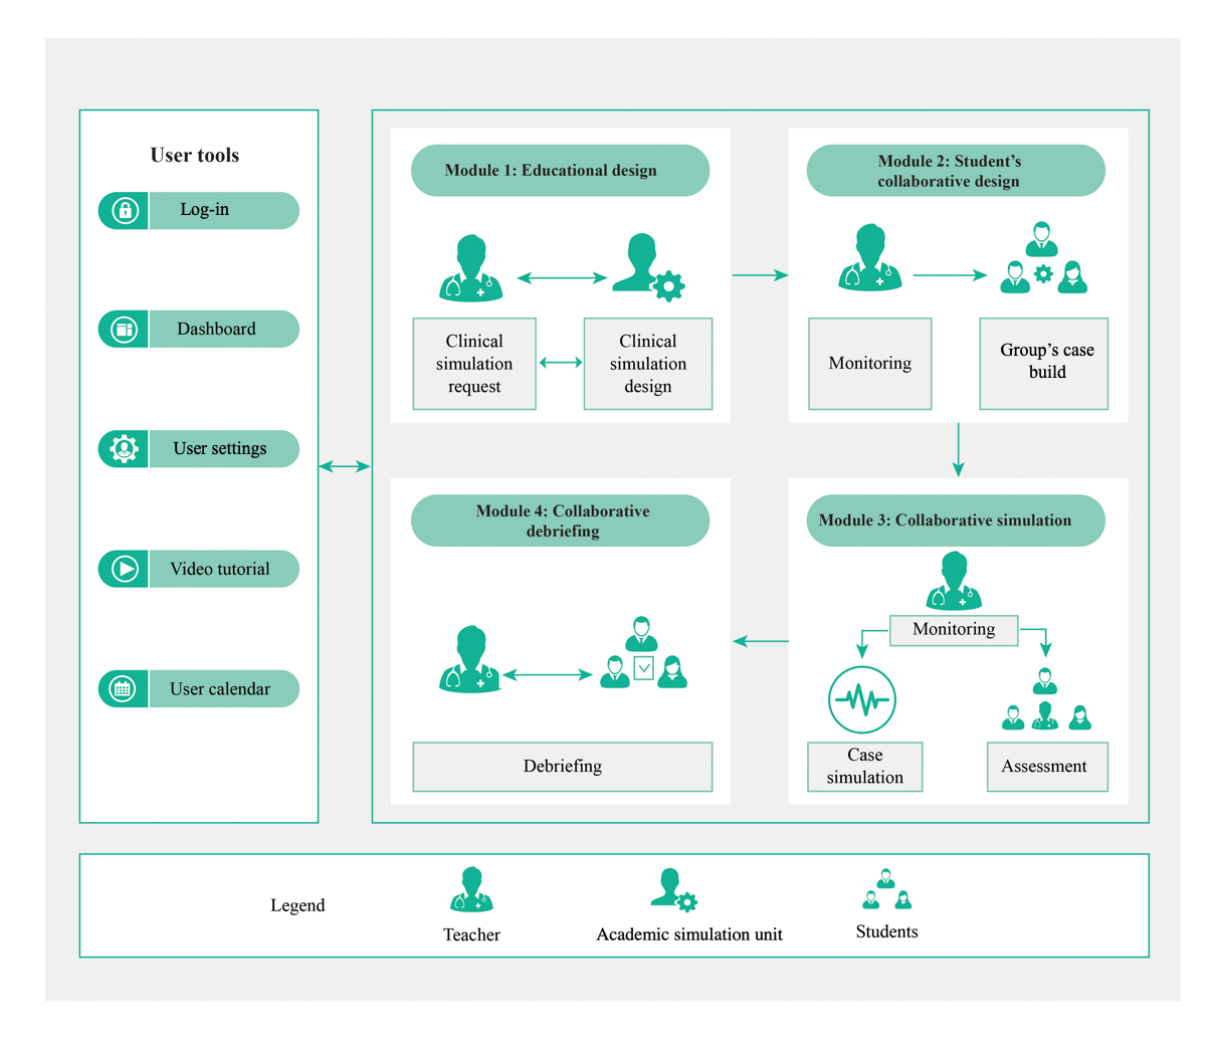
Figure 3. The different sequential layers designed and developed by the collaborative clinical simulation (CCS) software MOSAICO. Each module supports the CCS phases and uses technology to design, develop, and assess collaborative clinical scenarios for medical